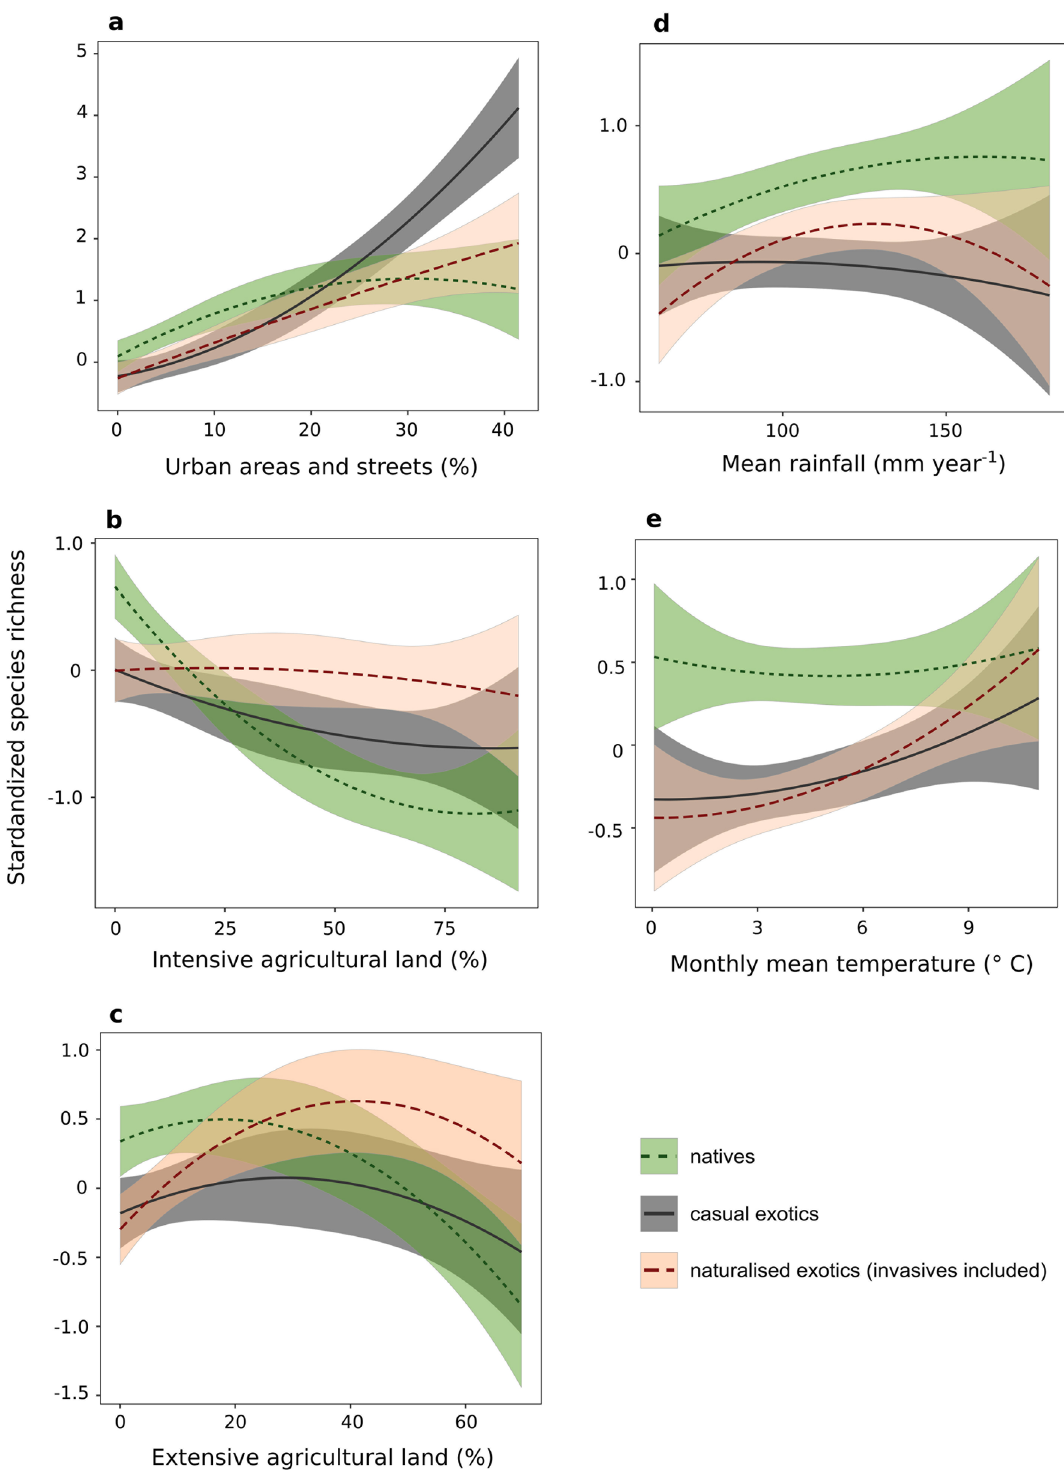
Figure 2. Best selected model using the Multi Model Inference analysis. The model (AIC = 0, R 2 = 0.69) shows the effects of urban ( a ), intensive and extensive agriculture ( b , c ) land uses, annual rainfall ( d ) and mean temperature ( e ) on native (dotted lines) and exotic (casual = solid lines, naturalised = dashed lines) standardised species